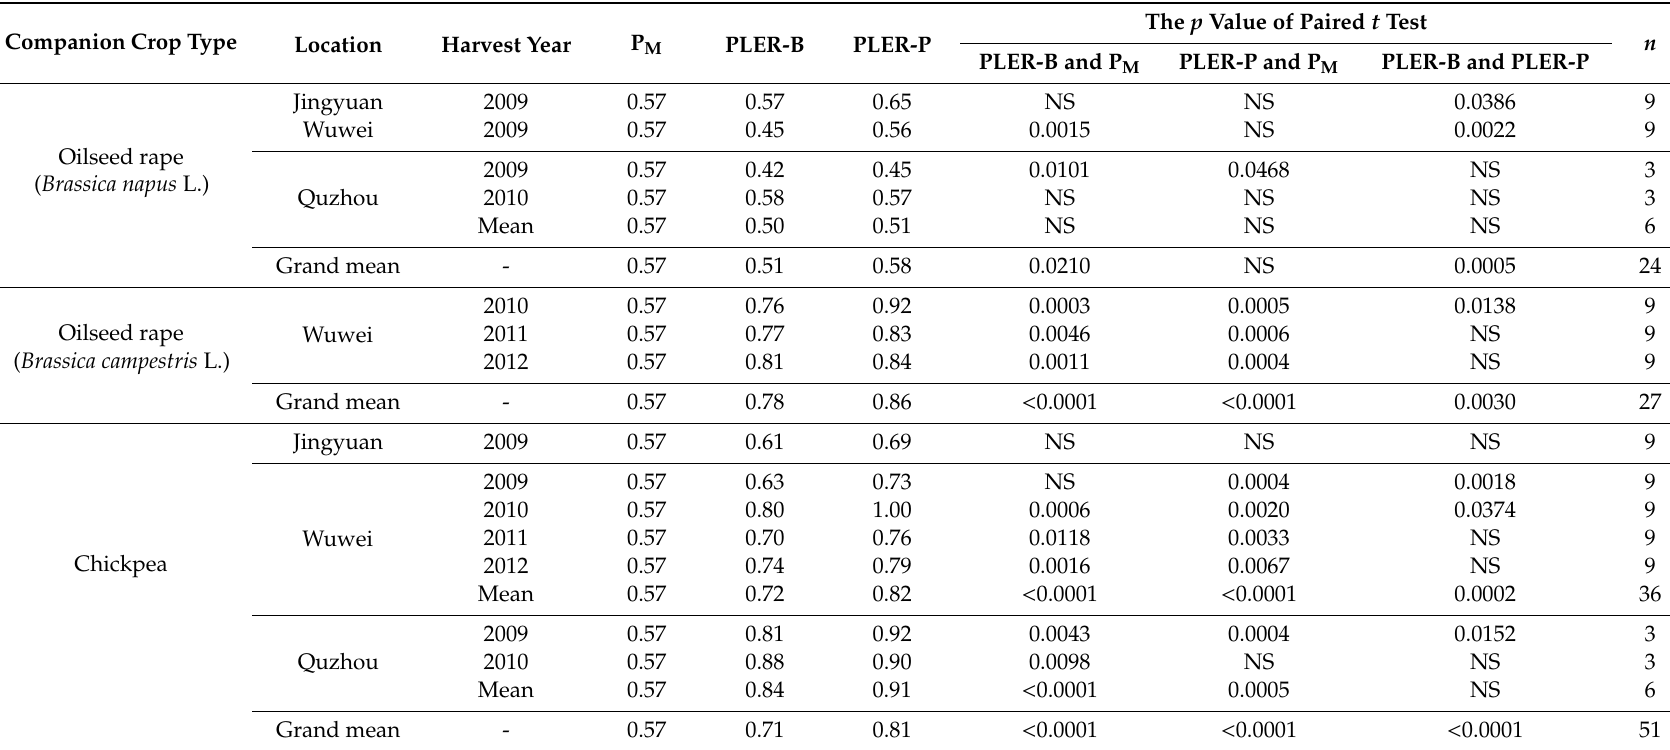
Table 7. Comparison of the partial land equivalent ratio (PLER) of shoot biomass (PLER-B) and shoot P content (PLER-P) of maize intercropped with di ff erent companion crops and the proportion of land area occupied by maize in the intercropping system (P M ) irrespective of P application rates across all experimental sites and study